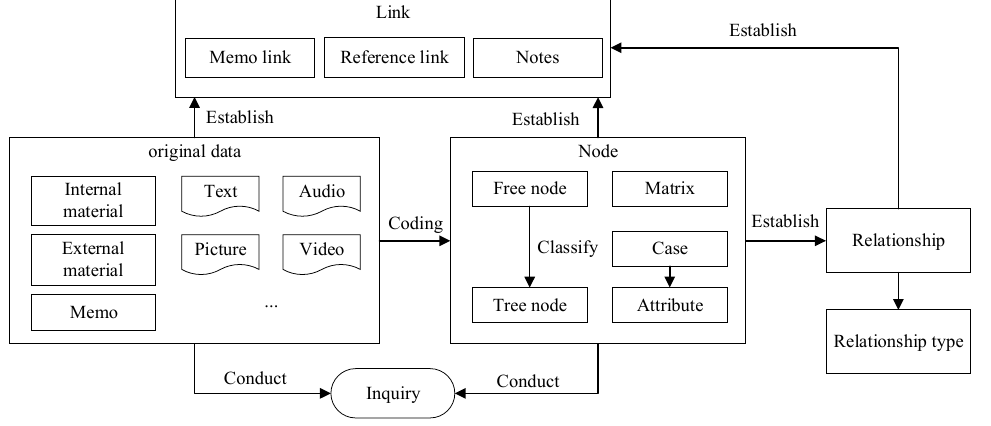
Figure 3. Qualitative-analysis flowchart.